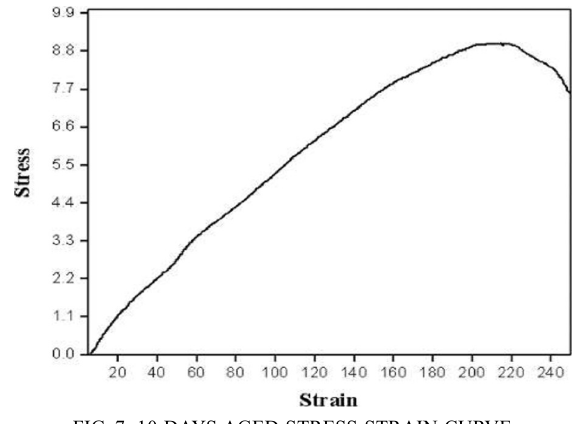
FIG. 5. STRESS STRAIN CURVE AGED FOR 5 DAYS